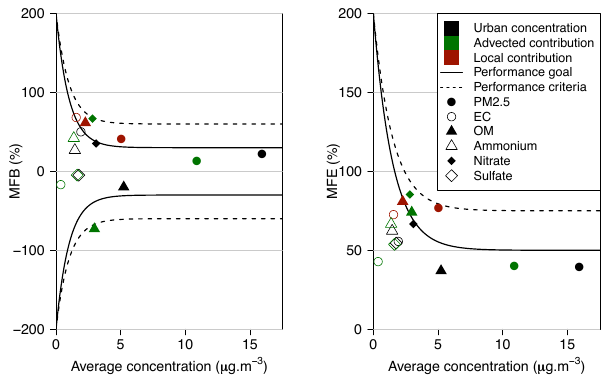
Figure 13. Mean fractional bias (left panel) and mean fractional er- ror (right panel) depending on the average concentration defined as the average of the mean observed and the mean simulated concen- tration. Urban background concentrations, advected and local con- tributions of PM 2 . 5 and all its compounds are reported, as well as performance criteria (dotted line) and goal (continuous line). Sec- ondary inorganics local contributions are not reported on the graph (see